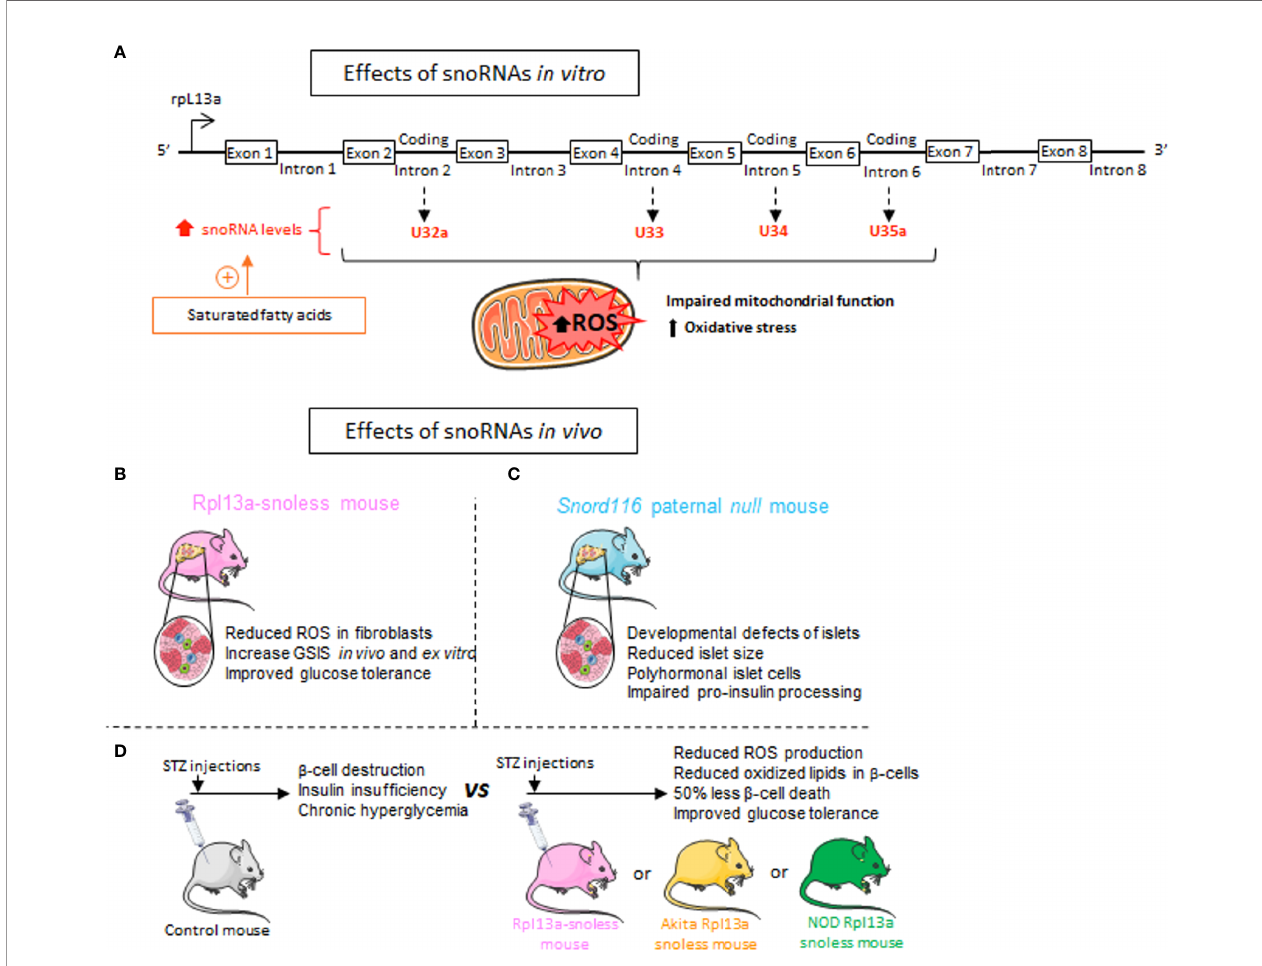
FIGURE 6 | Metabolic effects of snoRNAs. (A) Exposure of Chinese hamster ovarian cells and C2C12 Murine Myoblasts to saturated fatty acids including palmitate, results in an increase in the 4 snoRNAs encoded by the introns of Rlp13a gene. These four snoRNAs are known to induce 2 ’ -O-Methylations of target RNAs and mediate palmitate-induced lipotoxic effects on mitochondrial dysfunction and oxidative stress. (B) Mice invalidated for the 4 snoRNAs U32a (SNORD32a), U33 (SNORD33), U34 (SNORD34), and U35a (SNORD 35a) named Rpl13a-snoless mice, display reduced Reactive Oxygen Species (ROS) production, increased insulin secretion and improved glucose tolerance. (C) Rpl13a -snoless mice treated with the b -cell death inducer Streptozotocin (STZ) or bred with Ins2C96Y Akita mice or non-obese diabetic (NOD) mice are protected against the development of chronic hyperglycemia, show less oxidative stress and improved glucose tolerance. (D) Patients with Prader-Willi syndrome (PWS) who develop severe obesity and metabolic disorders carry a loss of paternally expressed genes on chromosome 15 which encodes for SNORD116. To reproduce the genetic background of PWS patients, a paternal Snord116 mouse knockout ( Snord116p – /m+ ) has been generated. Genetic deletion of SNORD116 leads to defects in pancreatic endocrine development along with metabolic